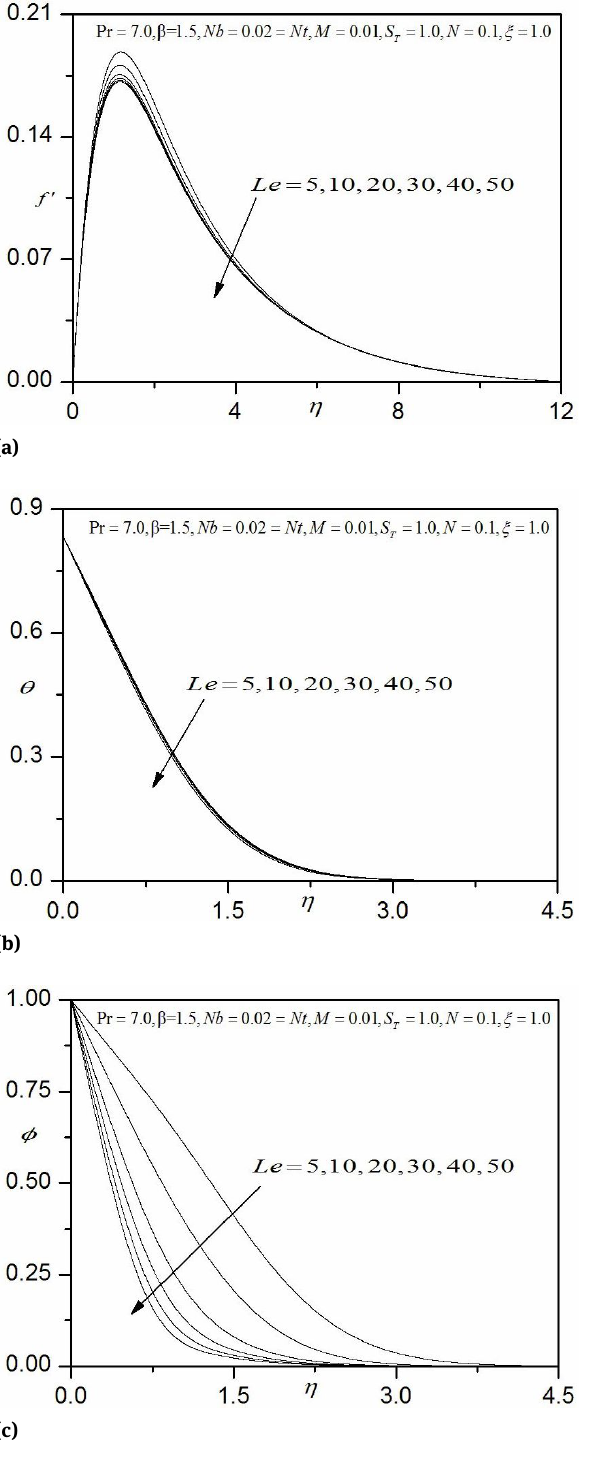
Fig. 5: Effect of Le on (a) velocity profiles, (b) temperature profiles, Fig. 6: Effect of M on (a) velocity profiles, (b) temperature